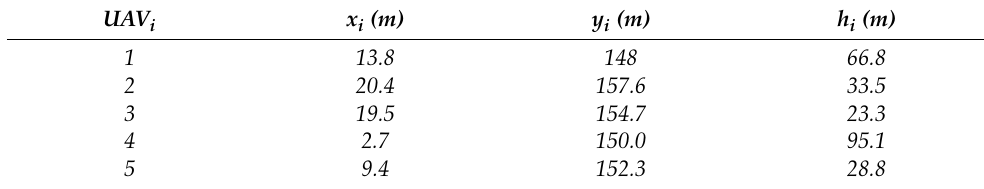
Table 7. Initial position parameters of five UAVs.